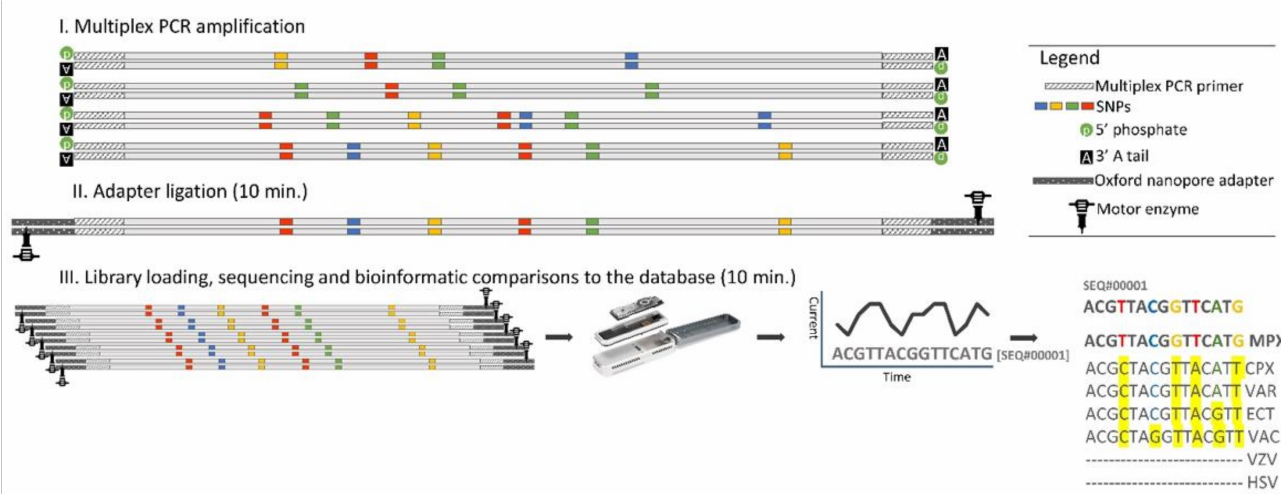
Figure 1. The RANS approach for the differential diagnosis of MPXV and other vesicle-forming pathogens. The figure elaborates on the rapid and comprehensive RANS procedure. The procedure starts with a suspected clinical sample and ends with a specific sequence-based identification in a timeframe of a few hours. (I). Multiplex PCR amplification, in which primers that are mutual for a group of viruses (for example OPVs) are used to amplify the whole group. A 5 (cid:48) phosphate (using a phosphorylated primer) and a dA tail (using the terminal transferase activity of the DNA polymerase and a final extension step of 15 min) were concurrently added at this stage. Next (II), an adapter ligation was performed, wherein the ONT-proprietary adapters, which were attached to a motor enzyme, ligated to the ends of the strands. The final step (III) involved library loading, sequencing, and base calling: The amplicons were loaded onto a Flongle apparatus and based-called FASTQ files were generated as the DNA was translocated through the nanopores. Finally, bioinformatic comparisons between the resulting sequences to a relevant database pinpointed the specific agent (in bold). The different viruses’ abbreviations are detailed in Table 1